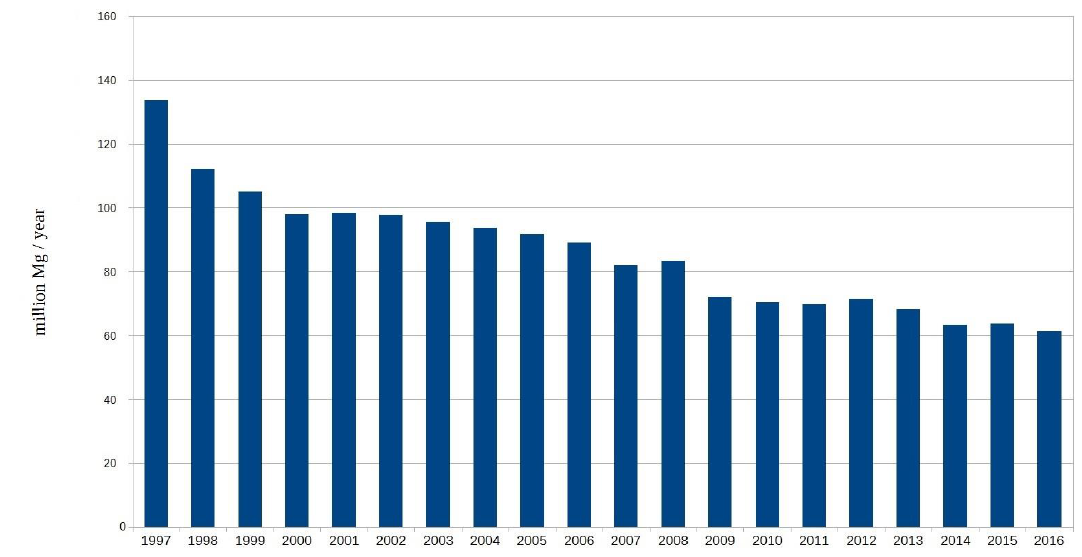
Fig. 4. Hard coal production in the Upper Silesia Coal